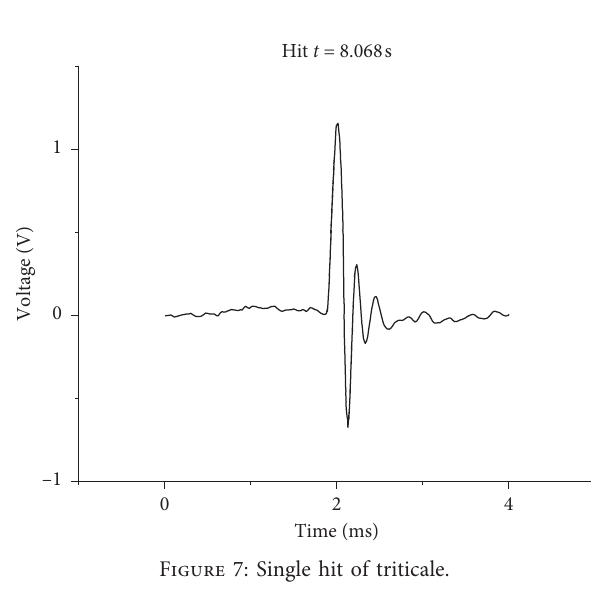
Figure 7: Single hit of triticale. Calculate standard deviation σ 1 and σ 2 of signal in two adjecent windows of